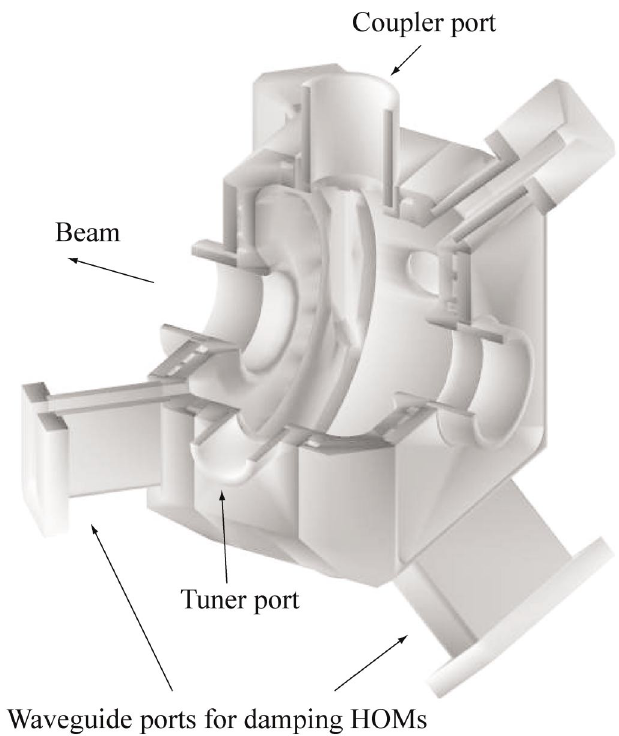
FIG. 1. 714-MHz damped-accelerating cavity for the ATF damping ring, where a quarter of the cavity is cut out. It is equipped with four waveguide ports for damping higher-order modes. The ends of the HOM ports are to be terminated by broadband dummy loads, which are not shown